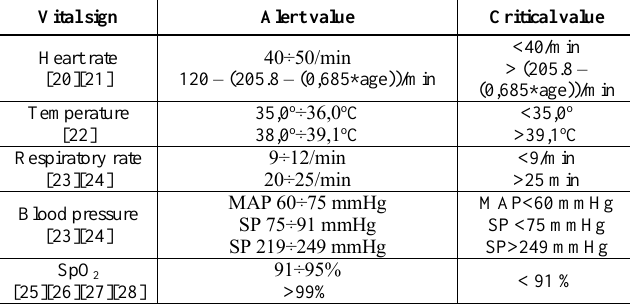
Table 2. Exemplary alert and critical values of vital signs considered in the